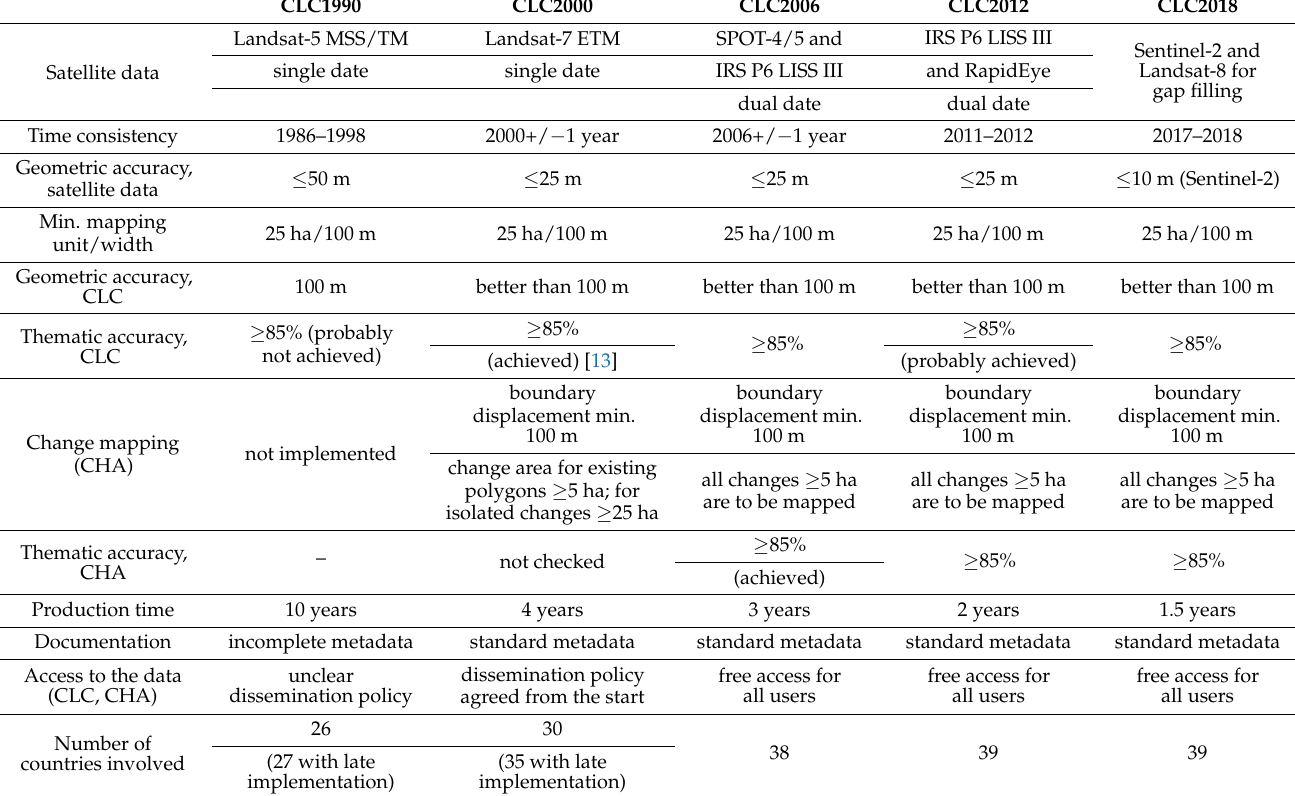
Table 1. Evolution of CORINE Land Cover. (Source: